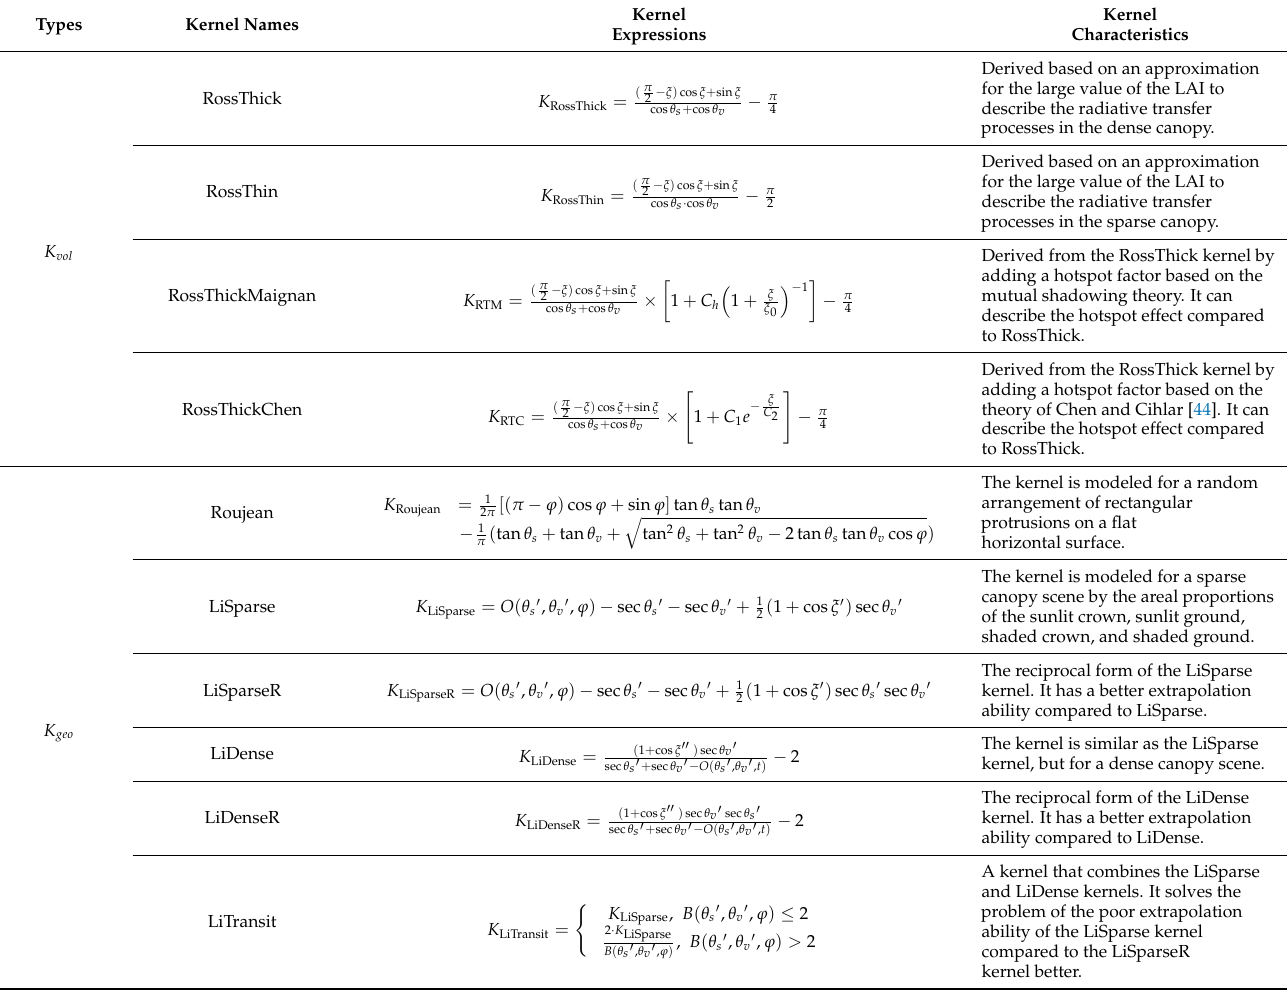
Table A1. The common volume-scattering and geometric-optical